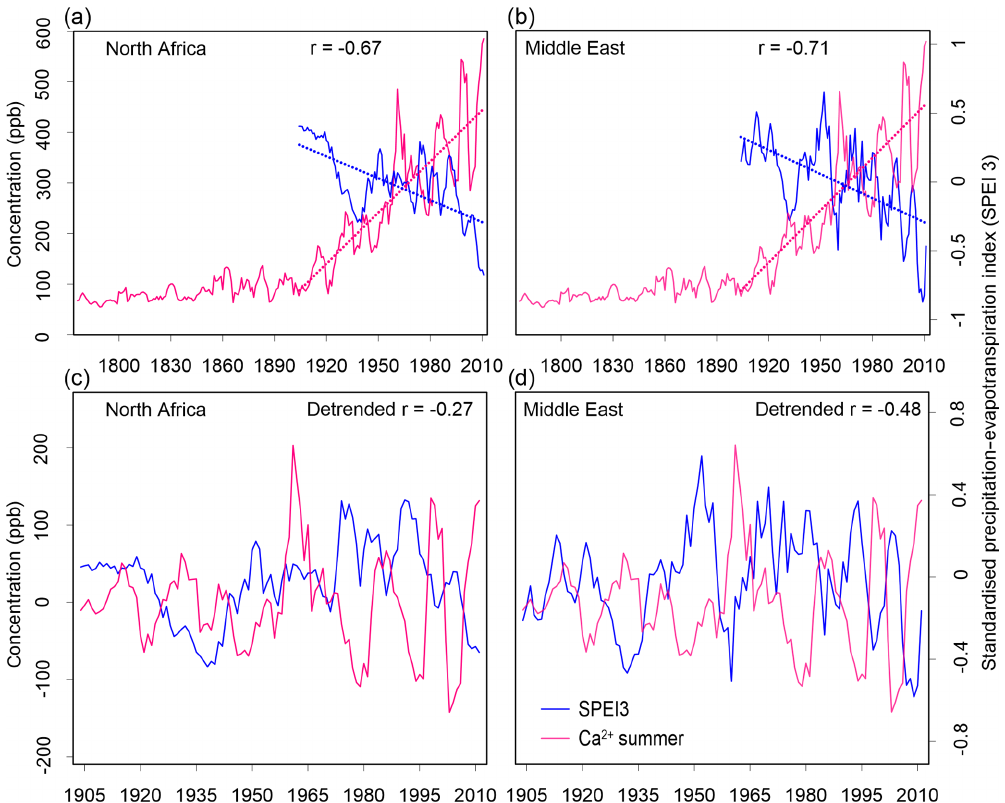
Figure 11. Ca 2 + and Standardised Precipitation-Evapotranspiration Index (SPEI3) averaged over the regions of (a, c) North Africa (20– 35 ◦ N, 0–35 ◦ E) and (b, d) the Middle East (32–37 ◦ N, 38–45 ◦ E). Outlines of the regions are presented on Fig. 10. Detrended records are shown at the bottom